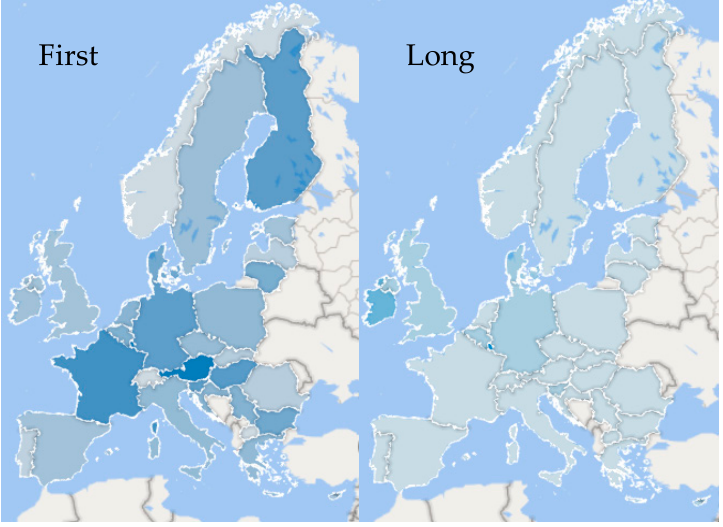
Figure 21. Number of precedence by country, first and long precedence group RD by effect. Geospatial distribution.